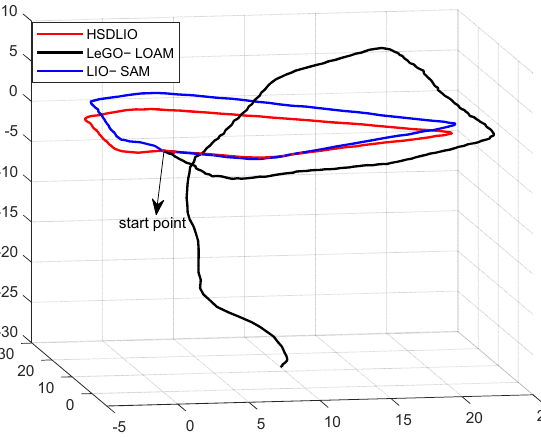
( b ) Figure 9. Comparison of mapping details at the top of the corridor , where ( a ) the mapping of LIO-